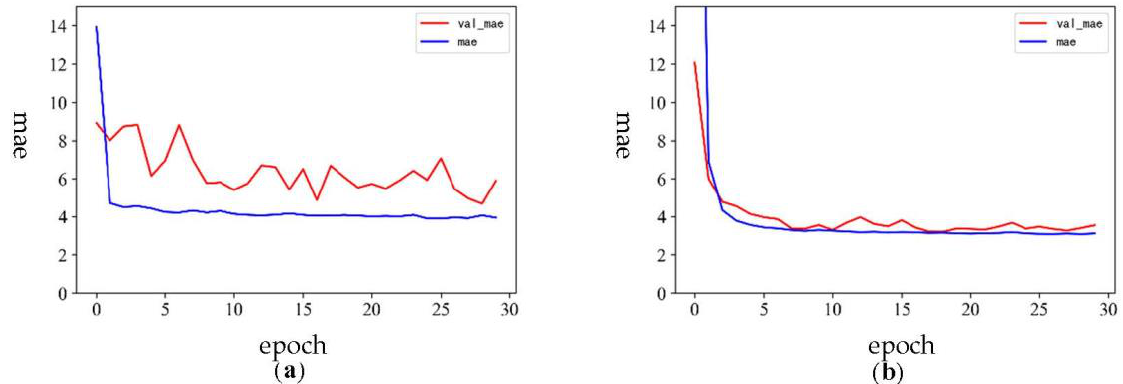
Figure 13. Comparison of learning curves before ( a ) and after ( b ) normalization: blue curves represent the error on the trained data, red curves represent the error on the test data.